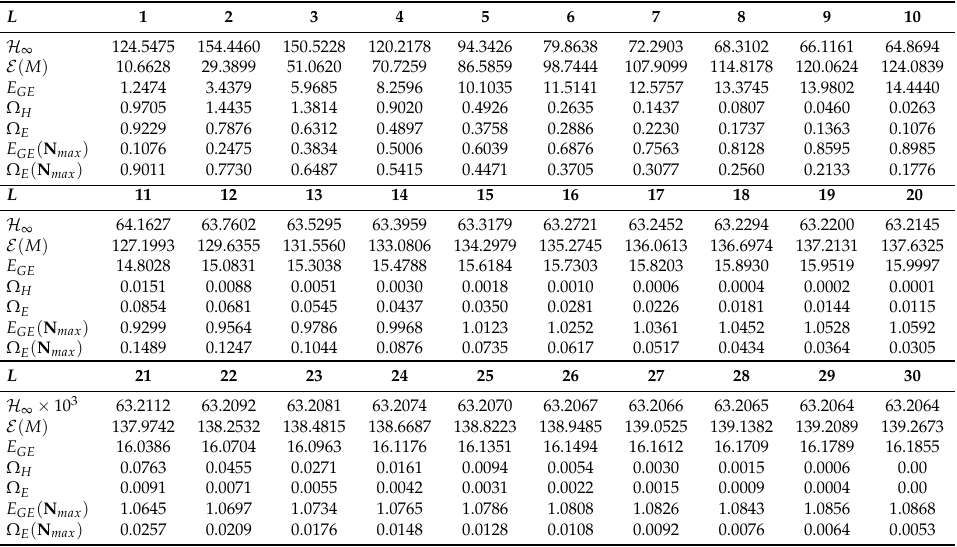
Table 5. Performance measurement indexes of the network for a single L